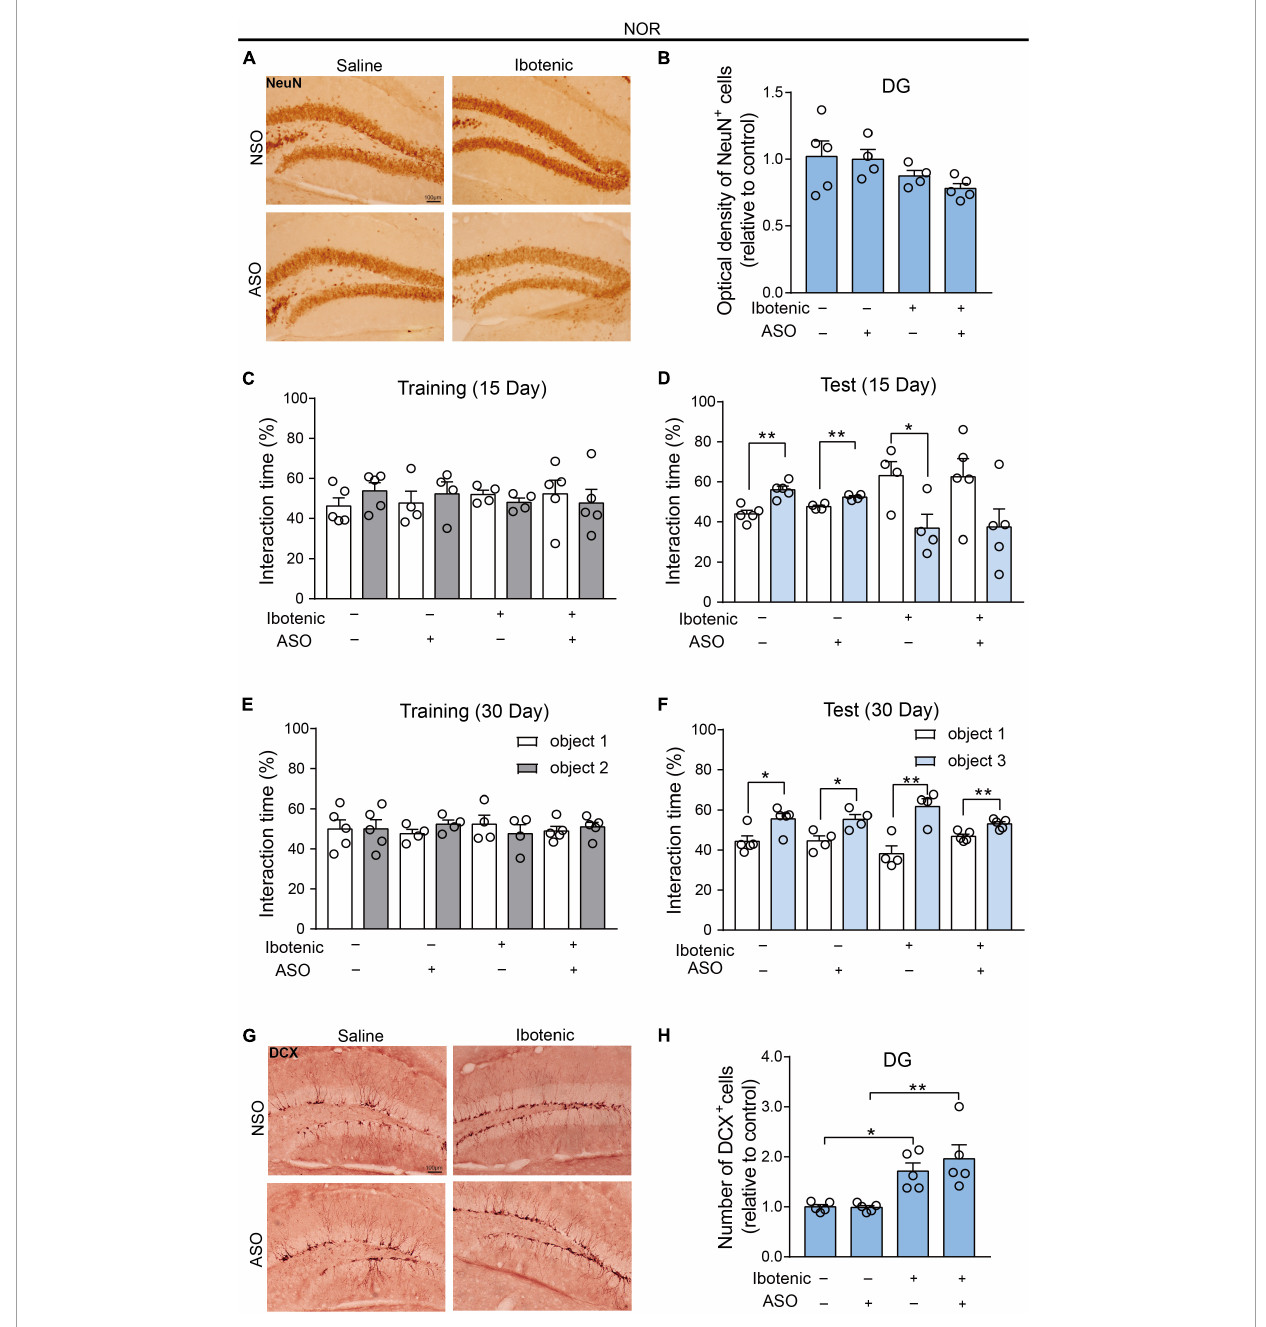
FIGURE5 The adult-born neurons contributed to the improvement of object recognition memory in DG-lesioned mice. (A) Representative images of NeuN-positive cells in the DG. Scale bar, 100 µ m. (B) The optical density of NeuN positive cells in the DG (saline/NSO: n = 5; saline/ASO: n = 4; Ibotenic/NSO: n = 4; Ibotenic/ASO: n = 5). Two-way ANOVA: Ibotenic, F ( 1 , 14 ) = 5.367, p = 0.0362; ASO, F ( 1 , 14 ) = 0.5271, p = 0.4798; interaction, F ( 1 , 14 ) = 0.2095, p = 0.6542. (C) The interaction time (%) of NOR during the training phase 15 days after ASO injection (saline/NSO: n = 5; saline/ASO: n = 4; Ibotenic/NSO: n = 4; Ibotenic/ASO: n = 5). Unpaired t -test: saline/NSO: t ( 8 ) = 1.305, p = 0.2282; saline/ASO: t ( 6 ) = 0.5483, p = 0.6033; Ibotenic/NSO: t ( 6 ) = 1.275, p = 0.2495; Ibotenic/ASO: t ( 8 ) = 0.4711, p = 0.6502. (D) The interaction time (%) of NOR during the test phase 15 days after ASO injection (saline/NSO: n = 5; saline/ASO: n = 4; Ibotenic/NSO: n = 4; Ibotenic/ASO: n = 5). Unpaired t -test: saline/NSO: t ( 8 ) = 4.744, ** p = 0.0015; saline/ASO: t ( 6 ) = 4.722, ** p = 0.0033; Ibotenic/NSO: t ( 6 ) = 2.672, * p = 0.0369; Ibotenic/ASO: t ( 8 ) = 1.968, p = 0.0847. (E) The interaction time (%) of NOR during the training phase 30 days after ASO injection (saline/NSO: n = 5; saline/ASO: n = 4; Ibotenic/NSO: n = 4; Ibotenic/ASO: n = 5). Unpaired t -test: saline/NSO: t ( 8 ) = 0.009471, p = 0.9927; saline/ASO: t ( 6 ) = 1.555, p = 0.1710; Ibotenic/NSO: t ( 6 ) = 0.7354, p = 0.4898; Ibotenic/ASO: t ( 8 ) = 0.6312, p = 0.5455. (F) The interaction time (%) of NOR during the test phase 30 days after ASO injection (saline/NSO: n = 5; saline/ASO: n = 4; Ibotenic/NSO: n = 4; Ibotenic/ASO: n = 5). Unpaired t -test: saline/NSO: t ( 8 ) = 2.923, * p = 0.0192; saline/ASO: t ( 6 ) = 3.066, * p = 0.0220; Ibotenic/NSO: t ( 6 ) = 4.267, ** p = 0.0053; Ibotenic/ASO: t ( 8 ) = 4.023, ** p = 0.0038. (G) Representative images of doublecortin (DCX) positive cells in the DG. Scale bar, 100 µ m. (H) The number of DCX-positive cells in the DG (saline/NSO: n = 5; saline/ASO: n = 5; Ibotenic/NSO: n = 5; Ibotenic/ASO: n = 5). Two-way ANOVA: Ibotenic, F ( 1 , 16 ) = 26.67, p < 0.0001; ASO, F ( 1 , 16 ) = 0.5129, p = 0.4842; interaction, F ( 1 , 16 ) = 0.6266, p = 0.4402; * p < 0.05, ** p < 0.01 with Bonferroni’s post-hoc